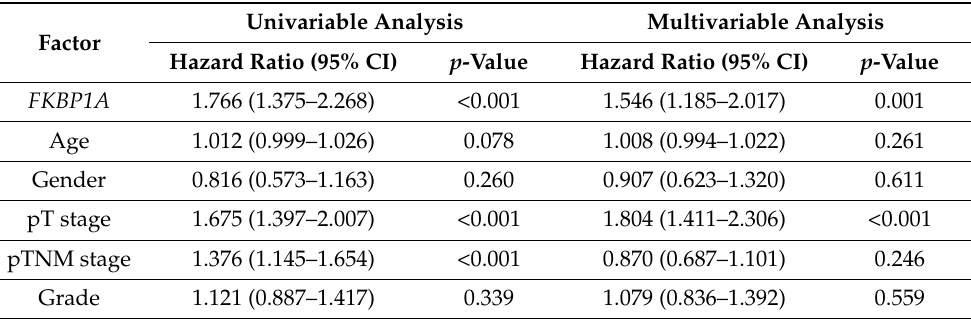
Table 2. Prognostic factors for overall survival in univariable and multivariable Cox proportional hazards analyses. Univariable Analysis Multivariable Factor